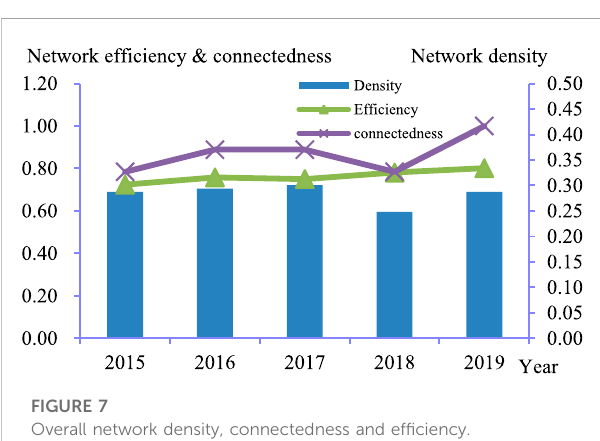
FIGURE 7 Overall network density, connectedness and ef fi